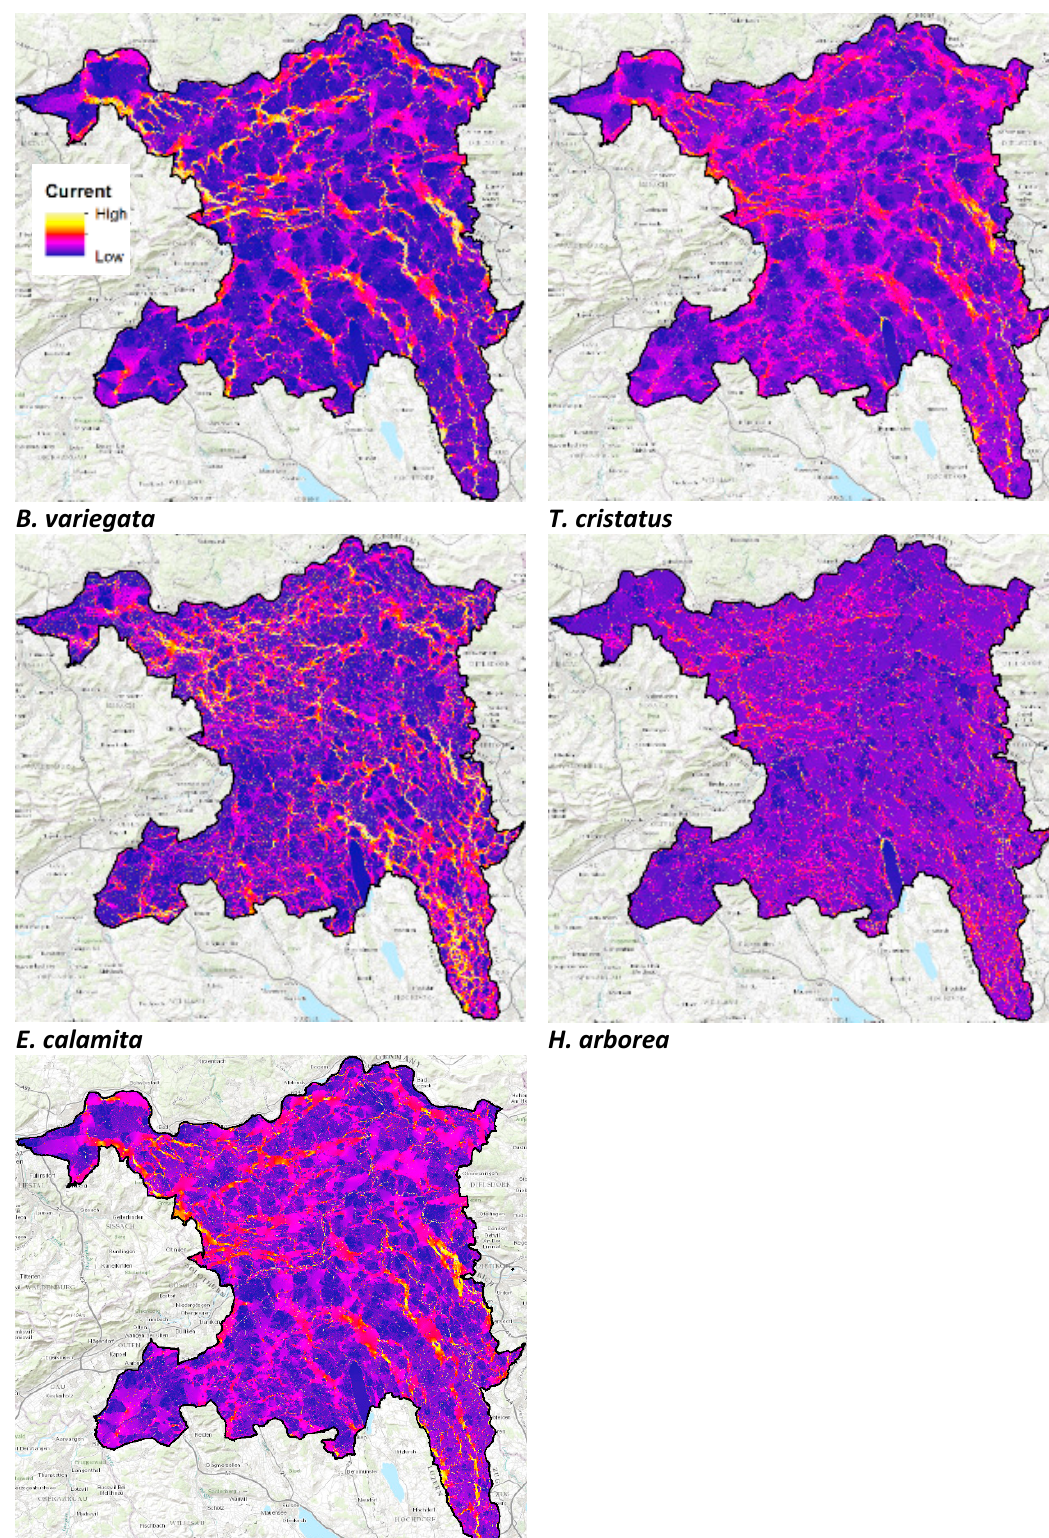
Figure A2. Structural connectivity maps for Bombina variegata , Triturus cristatus , Epidalea calamita , Hyla arborea , and Alytes obstetricans .